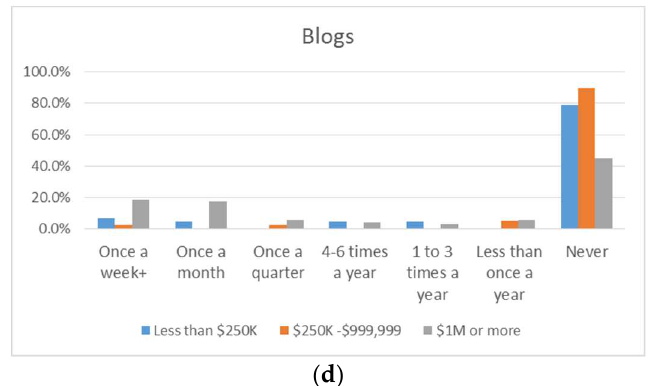
Figure 2. Frequency of use of new-media marketing tools by ornamental horticulture industry respondents in the study questionnaire: ( a ) Social media, ( b ) HTML newsletters, ( c ) websites, and ( d ) blogs. Categorized by 2014 sales: less than $250,000 ( n = 43); $250,000–$999,999 ( n = 39); and $1 million or more ( n = 69).